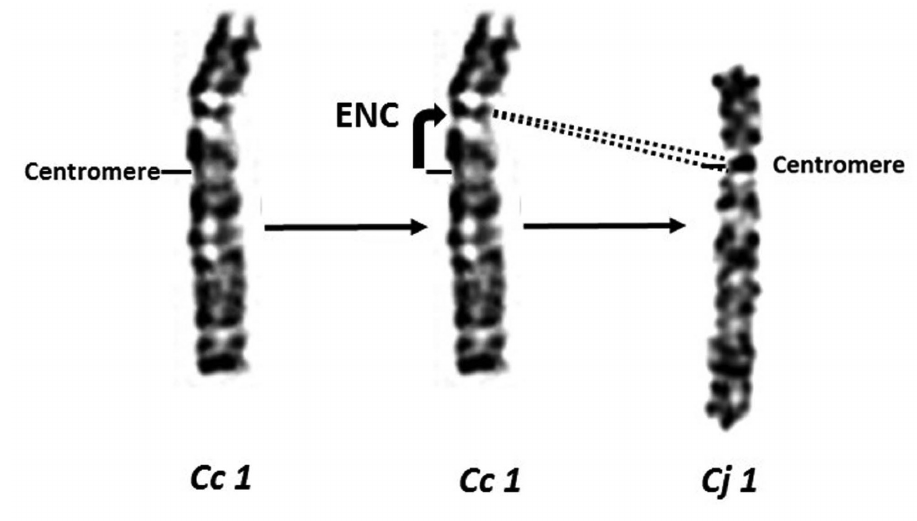
Figure 8. Evolutionary new centromere (ENC) formation on chromosome 1 of the Common and the Japanese quails.